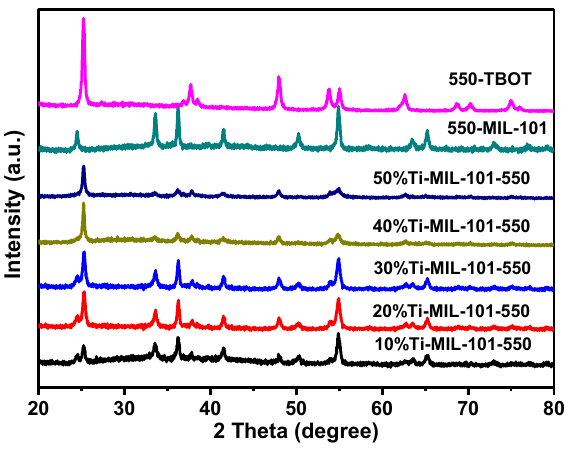
Figure 1. XRD patterns of various samples. Table 1. Particle sizes of various materials calculated from XRD patterns.